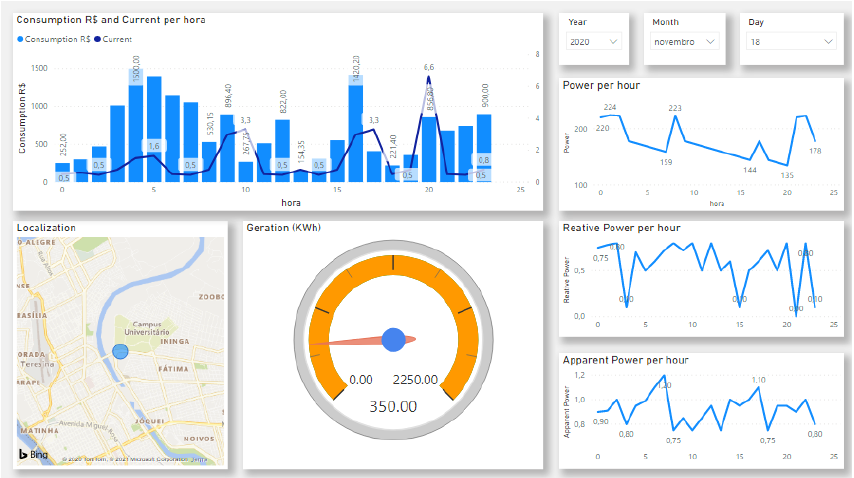
Figure 36. visualization of the final consumer’s energy consumption and generation data.